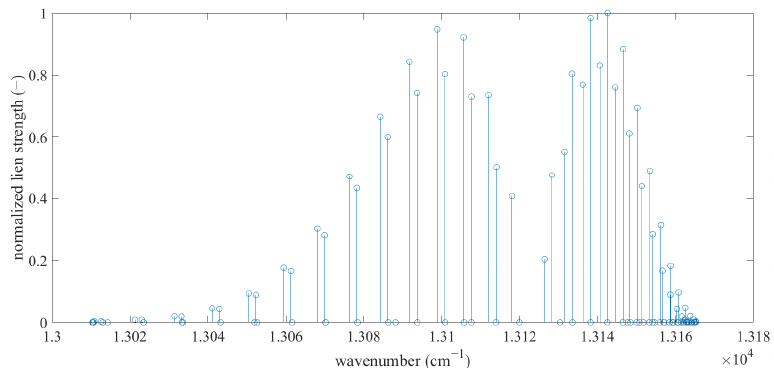
Figure 2. Fine spectral structure of O 2 A -band airglow.